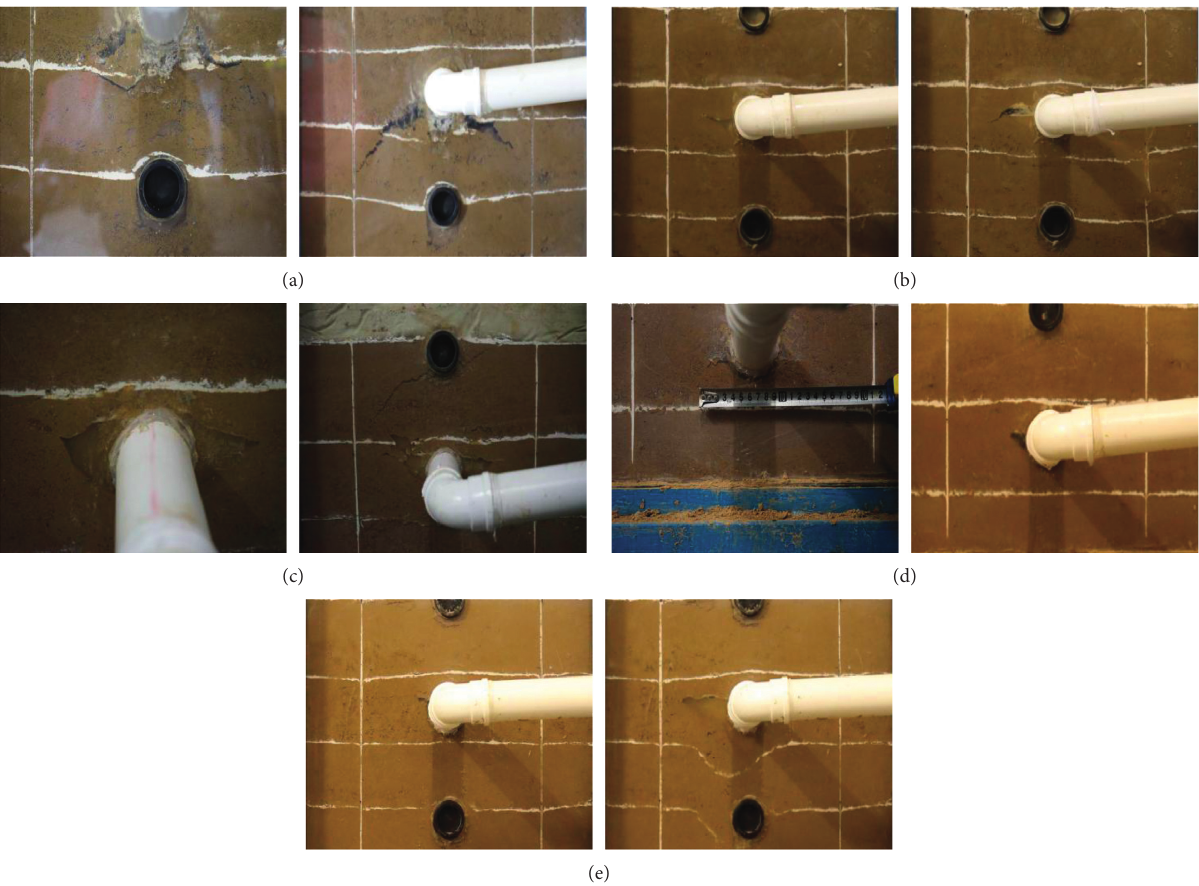
Figure 9: The development of void zone. (a) Condition 1. (b) Condition 2. (c) Condition 3. (d) Condition 4. (e) Condition 5.